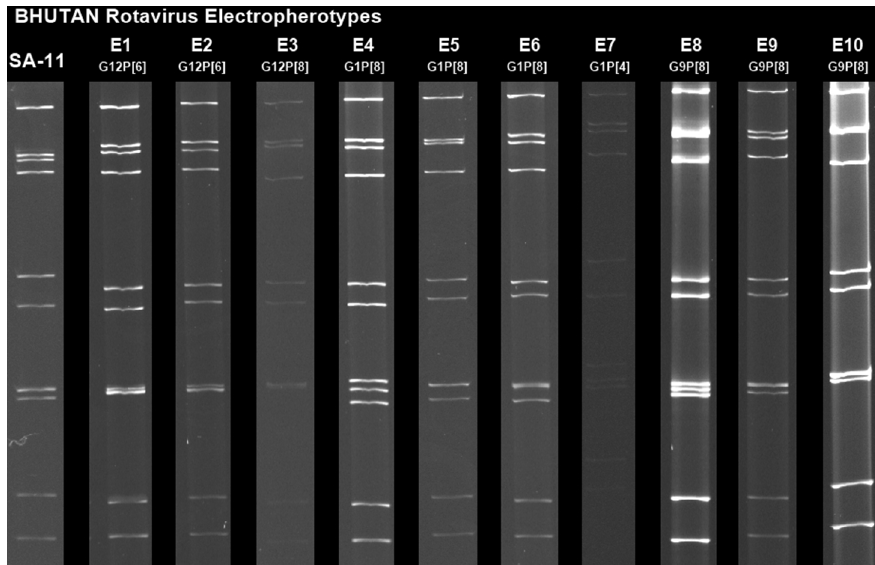
Figure 1. Electropherotypes of rotaviruses identified in Bhutan. On the extreme left, SA-11 indicates the electropherotype of strain Sa-11, which was used as a marker in each electrophoresis run. In total, 10 electropherotypes were identified, E1–E10. The genotype of each electropherotype is shown below the electropherotype. With the exception of E7, the electropherotypes had long patterns. Among five strains from Mongar, three were electropherotype E4, one E10, and one was